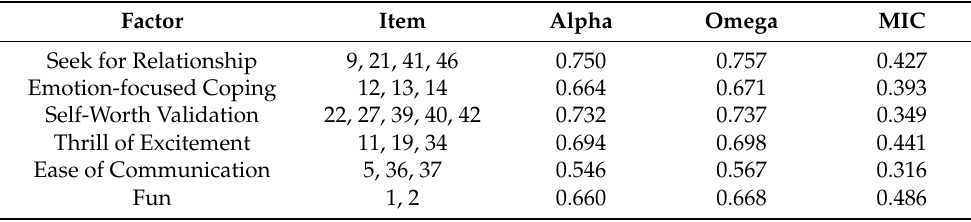
Table 6. Reliability of each